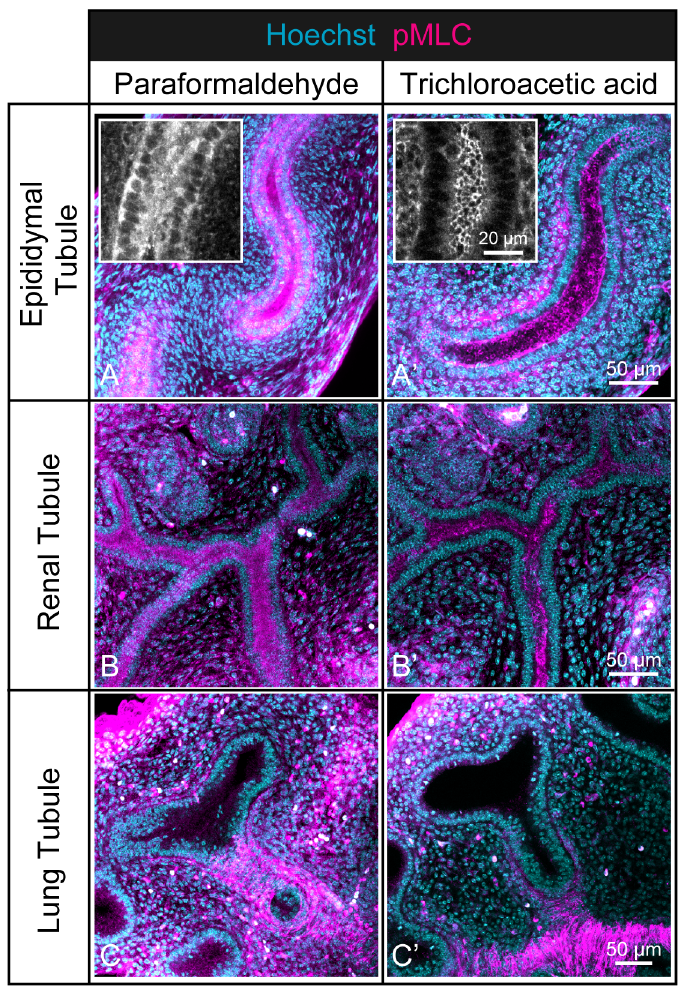
Fig 2. Comparison of phosphorylated myosin light chain immunofluorescence images obtained using different fixative solutions. Whole-tissue immunofluorescence of pMLC (magenta) was performed on the embryonic epididymis (upper), kidney (middle), and lung (bottom) tissues with a Hoechst dye (cyan) counter stain. Samples were chemically fixed with either 4% paraformaldehyde solution (left) or 2% trichloroacetic acid solution. Epididymis was dissected at E16.5, while the kidney and lung were dissected at E13.5. Scale bar: 50 μ m. In the small windows of Fig 2A and A 0 , only pMLC staining images were visualized, and the scale bar represents 20 μ m. For the images of immunolabeled pMLC, a maximum intensity projection was applied over 33 μ m with 1- μ m intervals for the three organs. The images containing Hoechst dye staining are single section